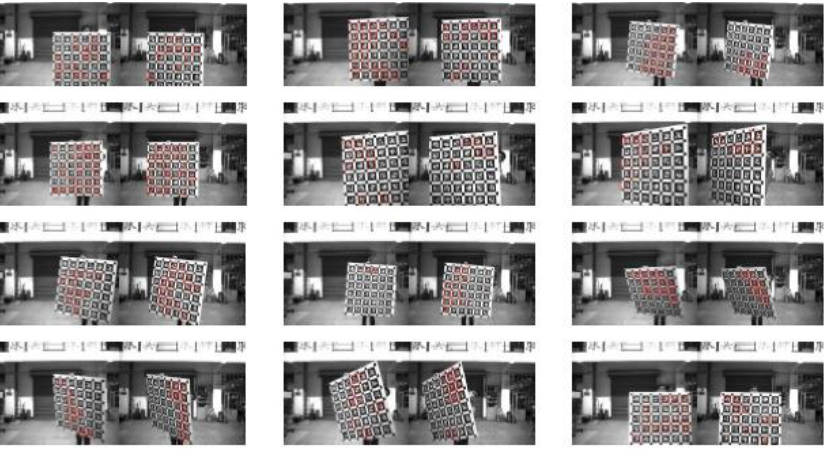
Figure 24. Twelve pairs of images collected at the same time (capture).